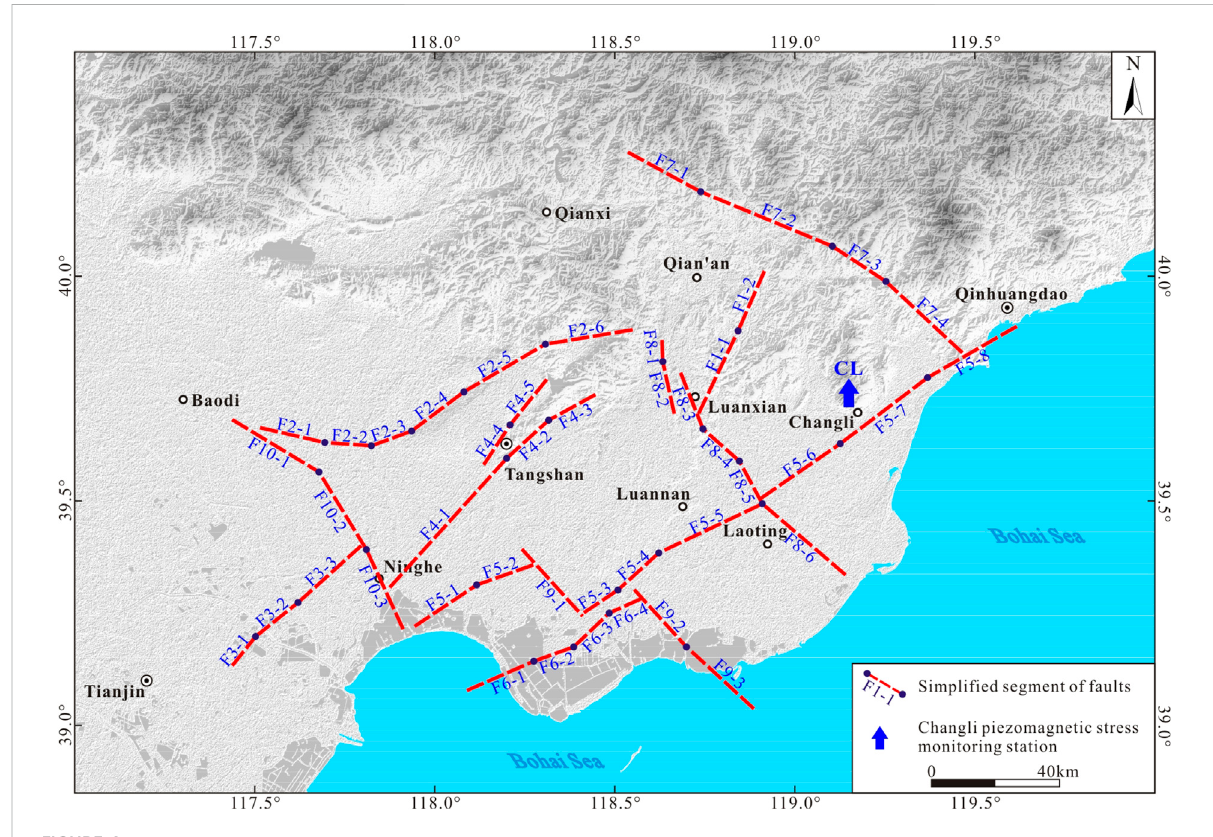
FIGURE 4 Simpli fi ed-segmental features of the main active faults in Tangshan seismic